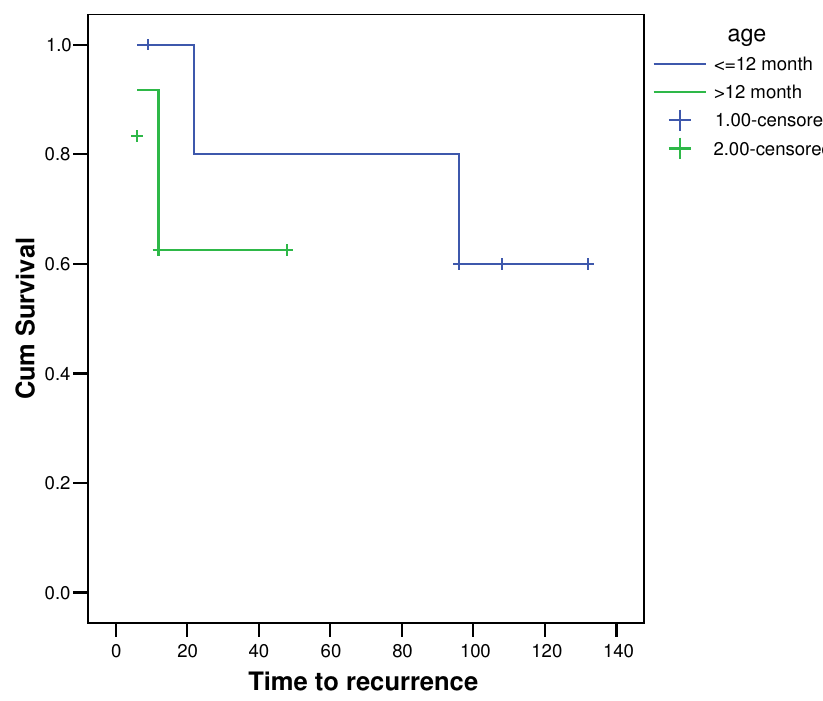
FIGURE 4. Kaplan-Meier survival curve of children with DCM (viral, familial, and idiopathic causes). Note the early high rate of death or transplantation at